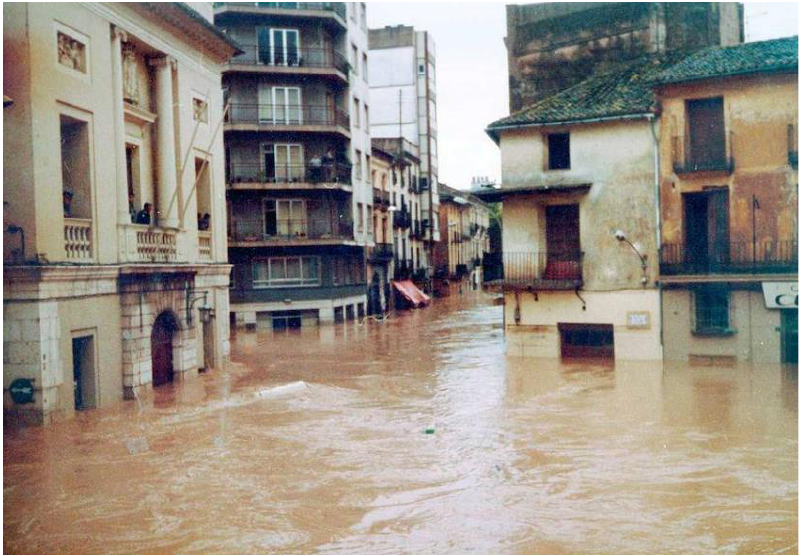
Figure 4. The flood called “Pantaná de Tous” (Júcar River), October 1982 . Source: Diario Las Pro- vincias [50].